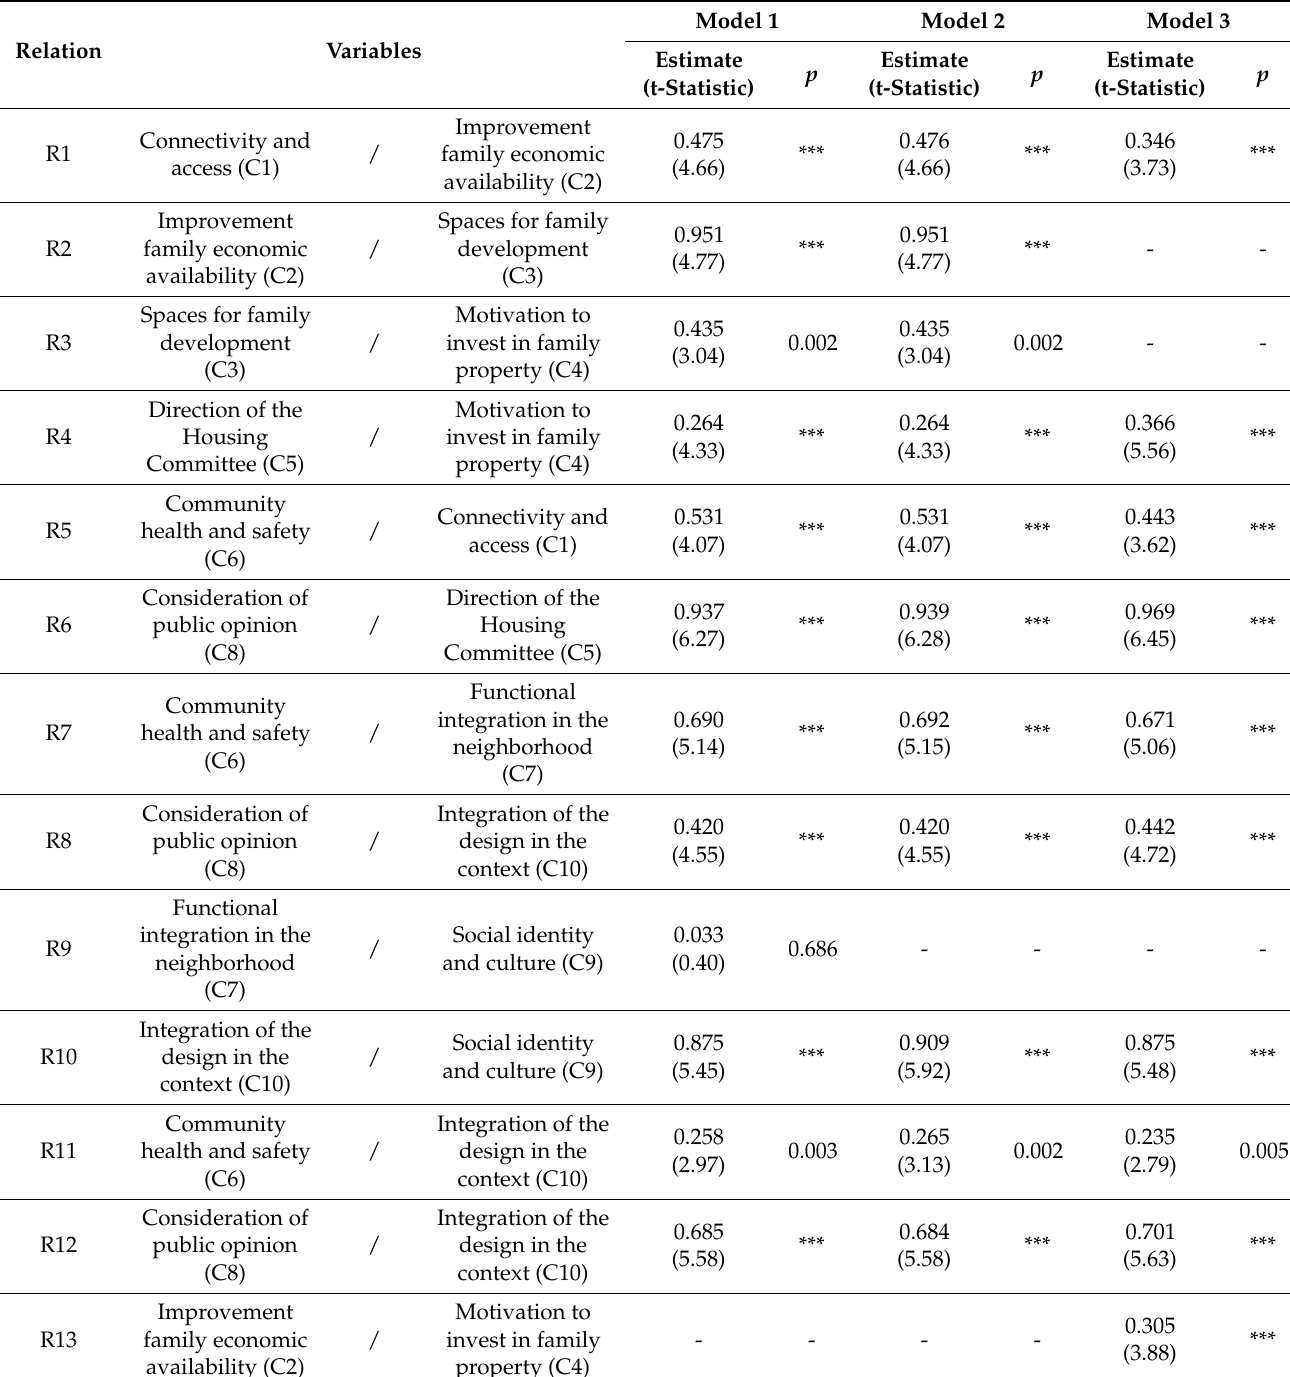
Table 5. Estimation of the